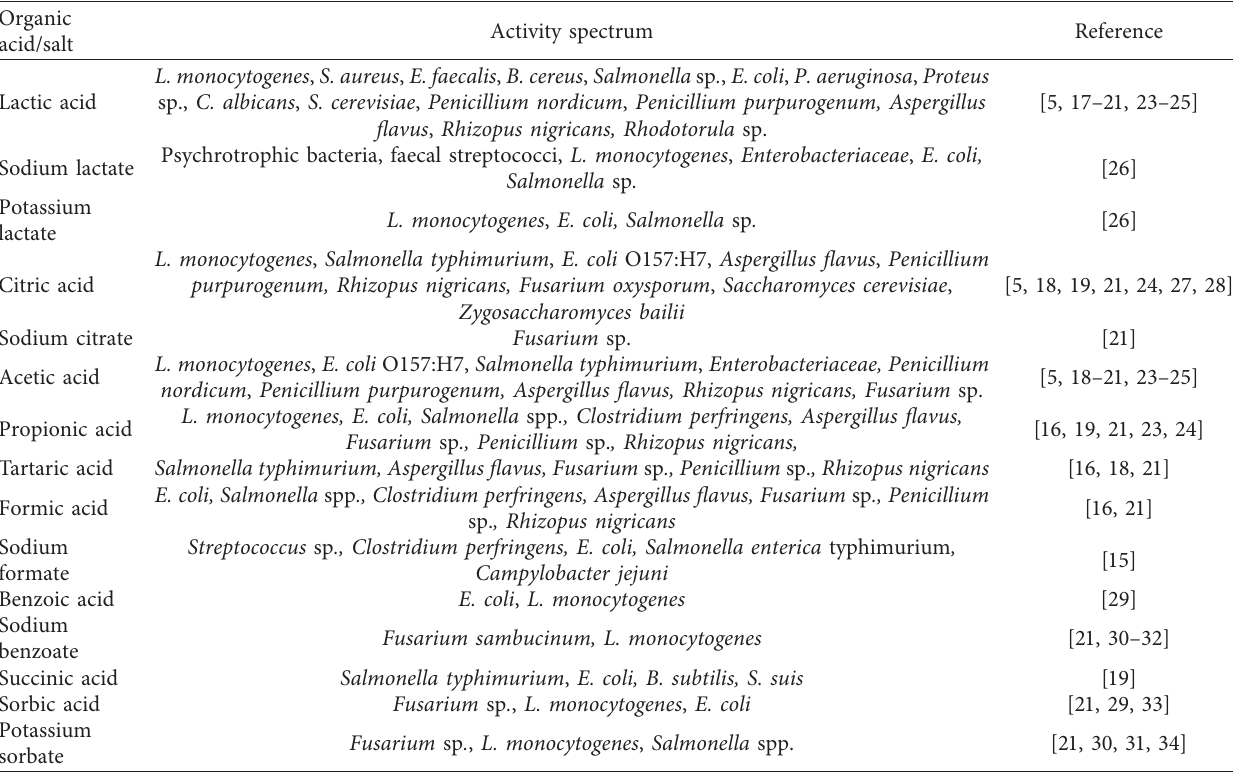
Table 2: Spectrum of action of frequently encountered organic acids and their